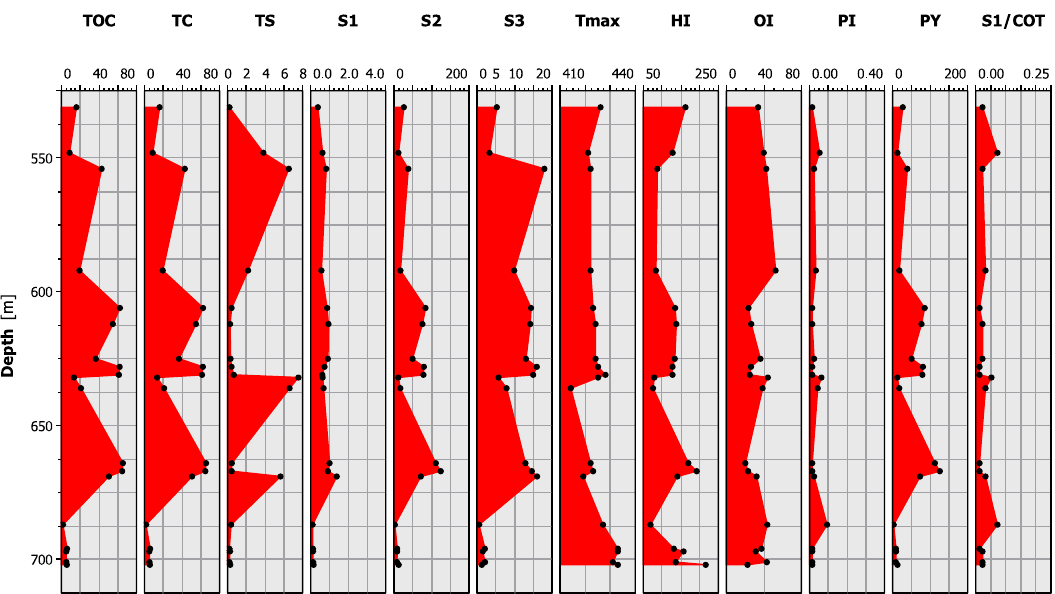
Figure 5. Results of geochemical analyses. Total organic carbon (TOC), total carbon (TC), total sulfur (TS), and Rock–Eval pyrolysis of the Cerrejón Formation rocks in the ANH-CAÑABOBA-1 Well, see Supplementary Materials Table S2.